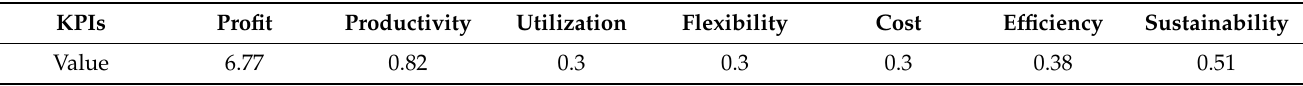
Table 6. Final goal value of the sustainability assessment method via goal decision model.